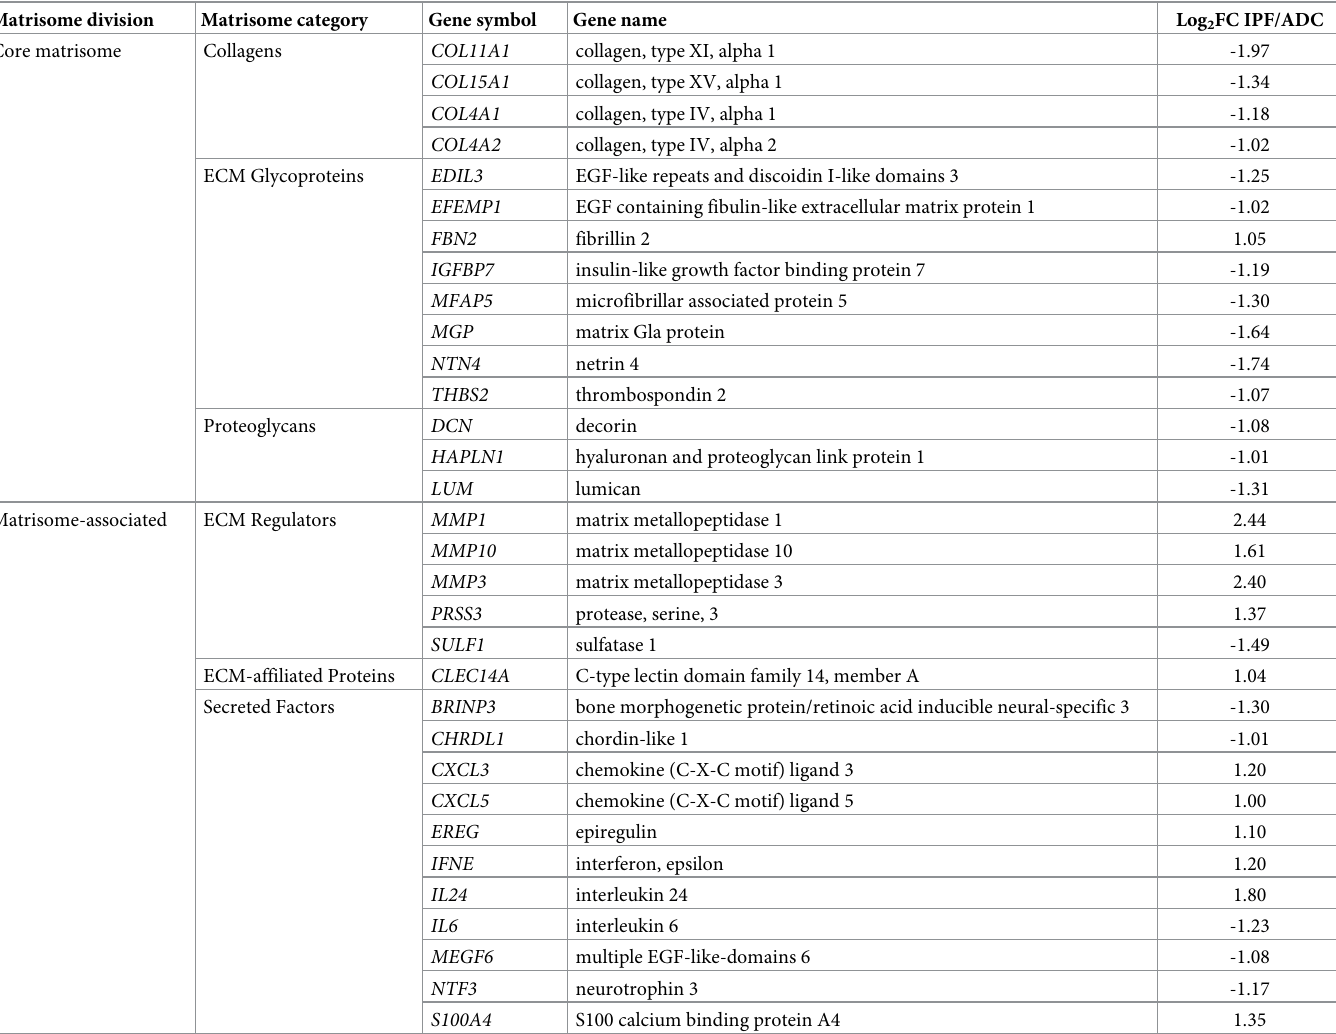
Table 4. Differentially expressed matrisome-associated genes in stromal cells derived from IPF compared to lung ADC. Matrisome